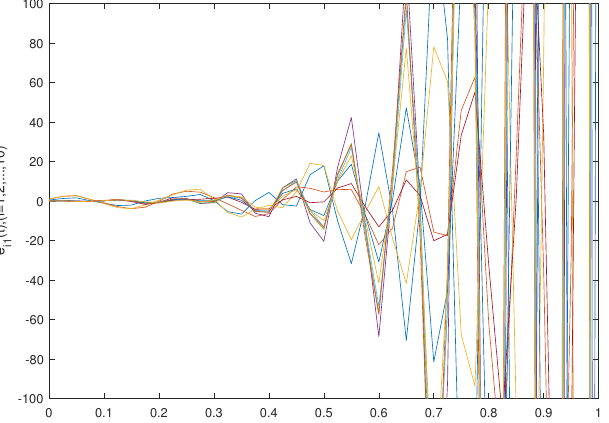
Figure 11. Synchronization errors e i 1 ( i = 1,2, · · · ,10 ) of the fractional-order system (34) and (35) without the controllers.